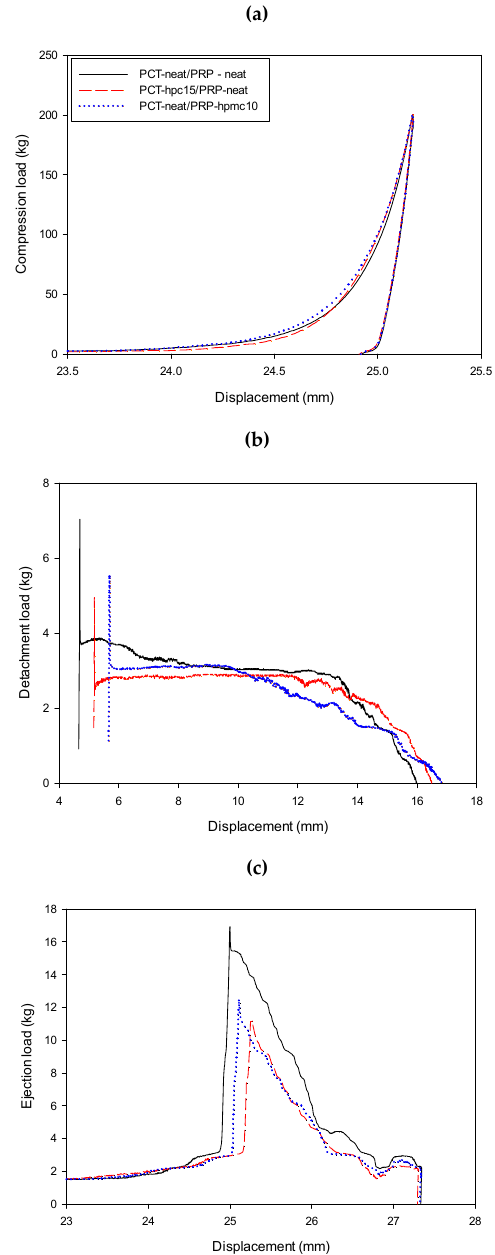
Figure 8. Force–displacement profiles of: ( a ) compression/decompression, ( b ) detachment and ( c ) ejection phases for optimal mixtures of PCT-hpc15 with neat PRP (PCT-hpc15/PRP) and PRP- hpmc10 with neat PCT (PRP-hpmc10/PCT). Profiles of the physical mixture of neat drugs (PCT/PRP) are also shown for comparison. Elastic recovery ( ER ) is associated with loss of interparticle bonds during decompres- sion and loss of tablet strength. From Table 5, it can be seen that ER remained high after